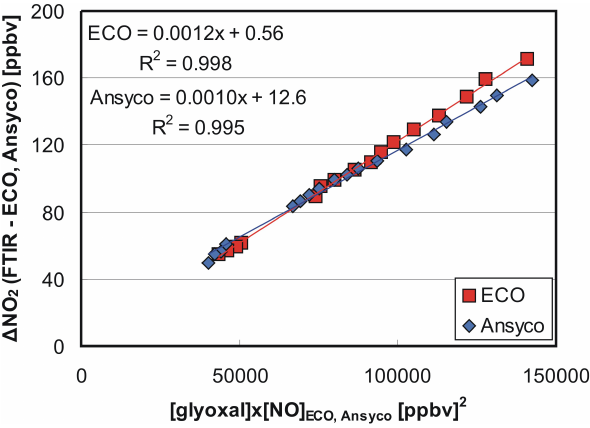
Fig. 5. Correlation of the negative interferences of the ECO Physics and the Ansyco blue light against the product [glyoxal] × [NO].